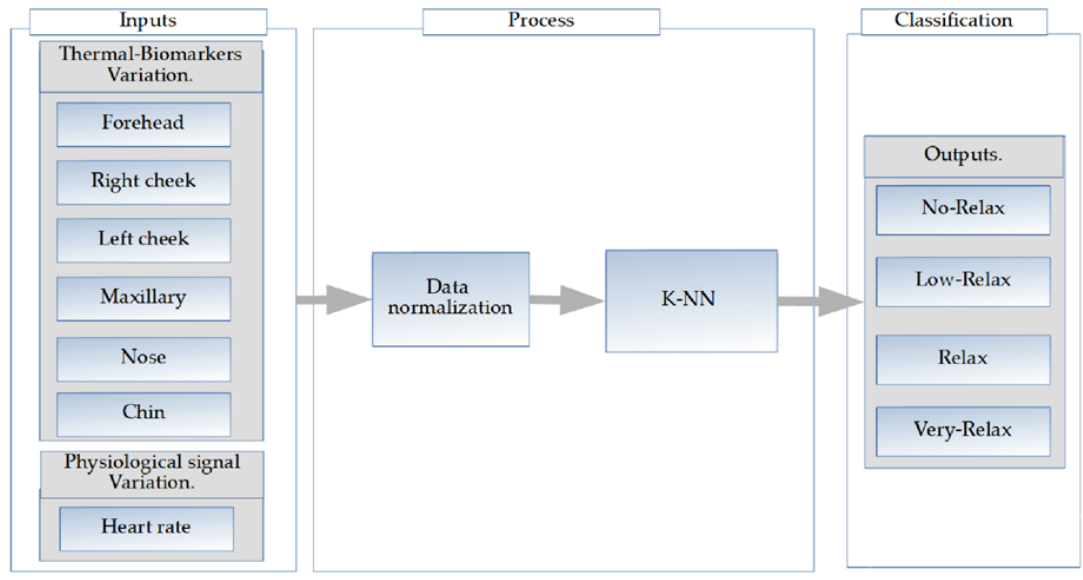
Figure 8. k-nearest neighbors (K-NN) inputs and outputs.